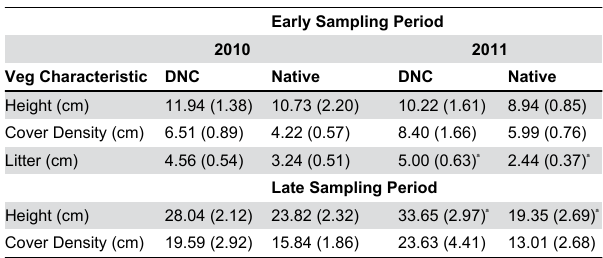
Table 2. Average vegetation height (SE), cover density, litter depth, and mixed model analysis of variance results for random locations in multi-species native plantings and dense nesting cover (DNC) during the early and late sampling periods from 2010–2011 in the Devils Lake Wetland Management District, North